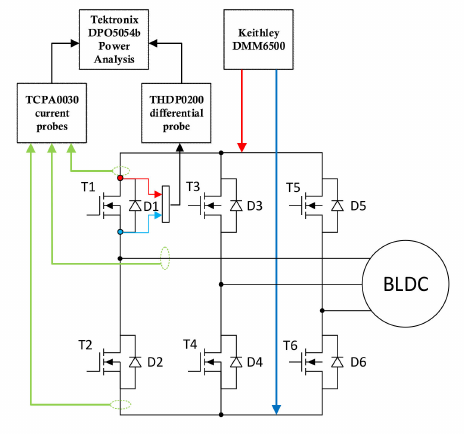
Figure 3. Laboratory measurement